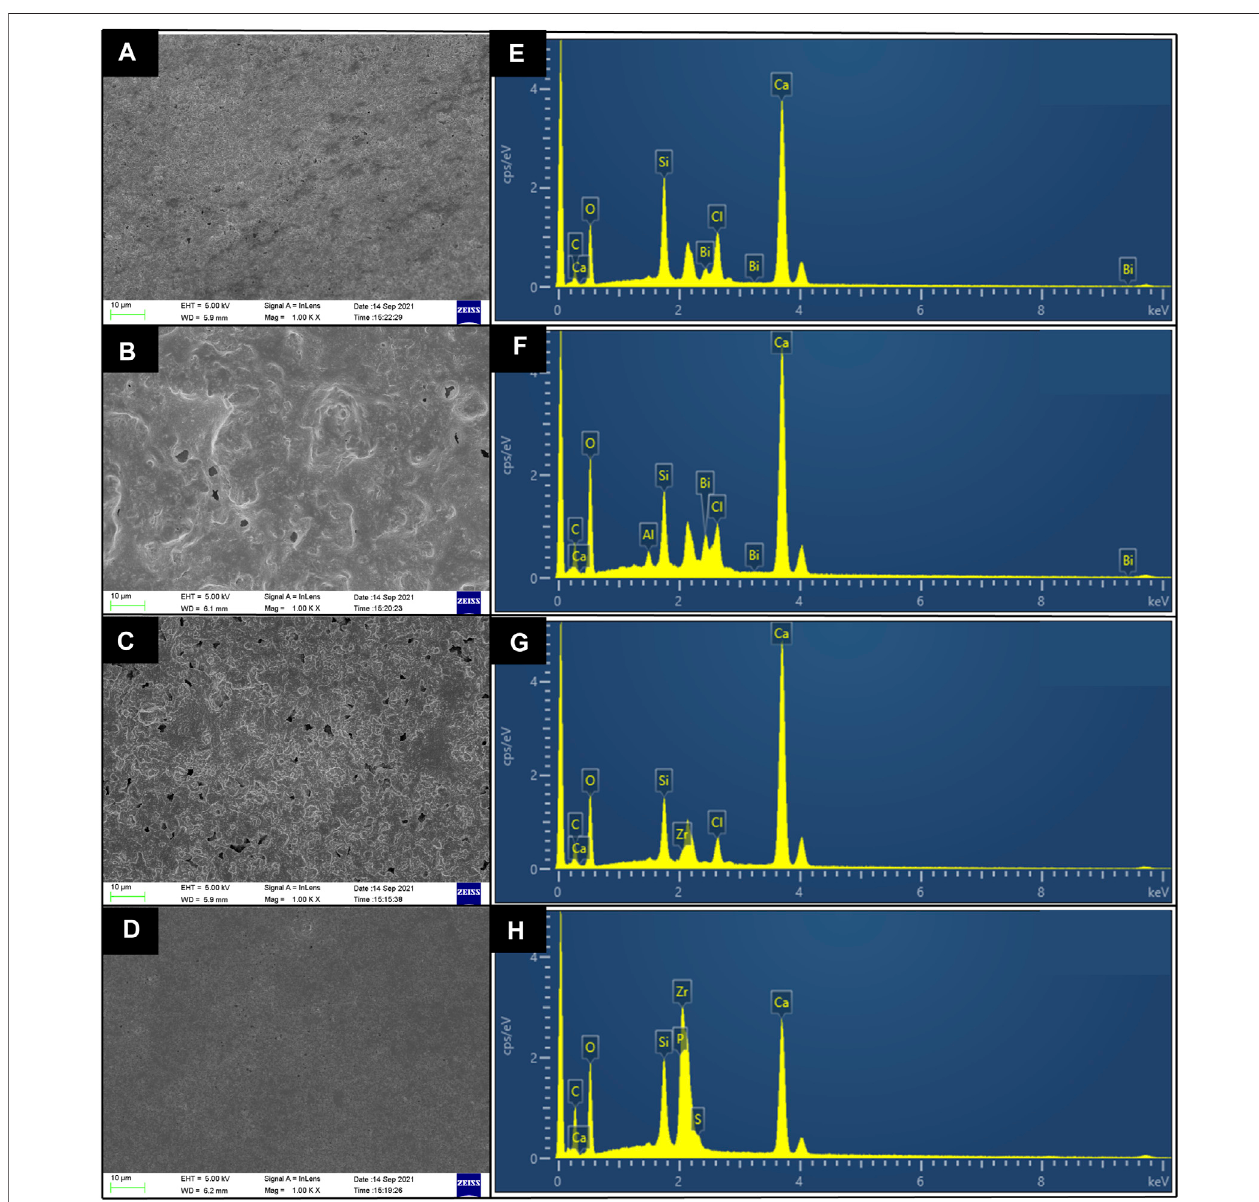
FIGURE 3 | SEM and EDX analyses of RDSC (A,E) , WMTA (B,F) , Biodentine (C,G) , iRoot BP plus (D,H) .